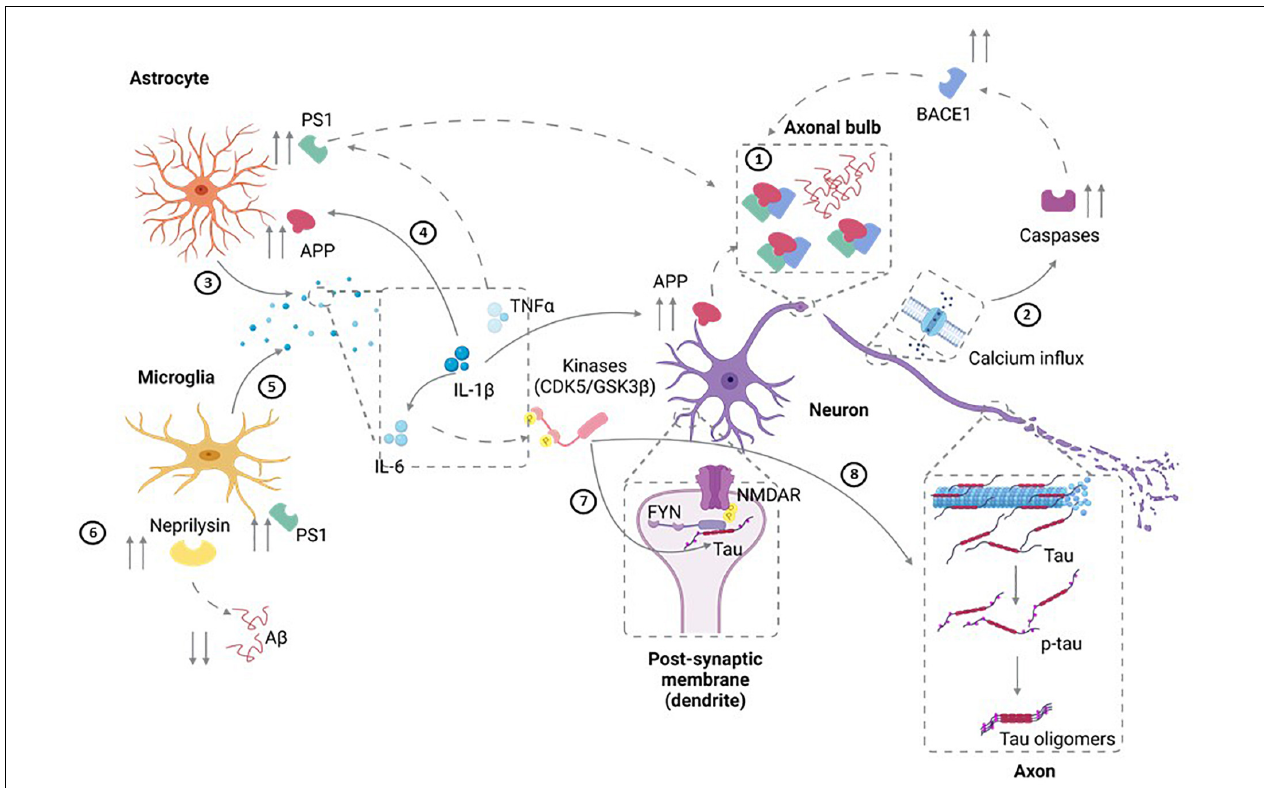
FIGURE 1 | Potential Mechanisms for TBI-Induced AD. (cid:192) Diffuse axonal injury that results from TBI can lead to upregulation of APP as well as increased amyloidogenic processing of APP to pathogenic A β 40 and A β 42. In addition, axonal degeneration could also lead to the extracellular release of A β . (cid:193) Injury can also result in calcium influx in neurons. In turn, this can result in activation of caspases that induce the amyloidogenic processing of APP through elevated BACE1 availability. (cid:194) Injury-induced cytokine release (IL-1) by astrocytes can also result in (cid:195) the upregulation of APP expression and an associated increase in its amyloidogenic progressing through upregulation of BACE and PS1. (cid:196) Along similar lines, microglial activation and production of IL-6, IL-1 and TNF α can increase APP transcription, upregulation of PS1, and increased amyloidogenic APP processing. (cid:197) TBI also can modulate A β clearance by neprilysin generated by microglia leading to aberrant clearance of A β . (cid:198) Cell injury can also elevate FYN tyrosine kinase activity leading to increased tau phosphorylation as well as activation of the NMDAR subunit NR2B, thereby modulating synaptic plasticity and increasing excitotoxic vulnerability. (cid:199) IL-6 upregulation post-injury can also lead to tau hyperphosphorylation through elevated MAPK-p38 signaling. Figure was generated with the assistance of